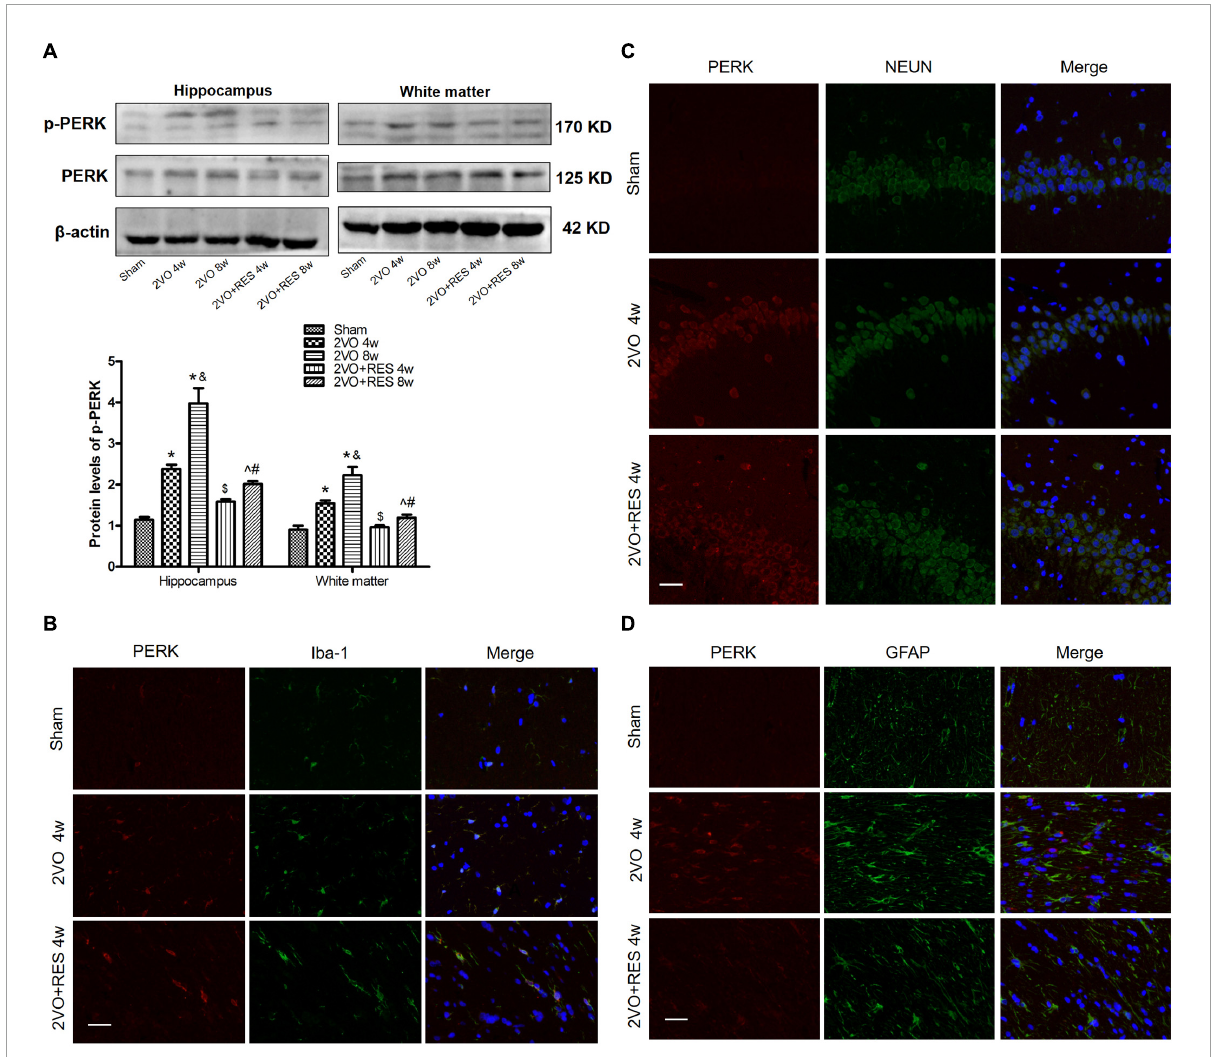
FIGURE8 Aberrant endoplasmic reticulum (ER)-stress in the bilateral common carotid artery occlusion (2VO) model is partially prohibited by resveratrol (RES). (A) The protein levels of PKR-like ER kinase (PERK) and p-PERK in white matter and hippocampus of different groups were measured by Western blotting. β -actin was used as an internal control ( n = 3 per group). The presence of p-PERK (red) in microglia (B) , neurons (C) , and astrocytes (D) was tested by immunofluorescence ( × 400, Blue, DAPI, n = 3 per group). * p < 0.05 vs. Sham; & p < 0.05, 2VO 8w group vs. 2VO 4w group; # p < 0.05, 2VO + RES 8w group vs. 2VO + RES 4w group; $ p < 0.05, 2VO + RES 4w group vs. 2VO 4w group; ˆ p < 0.05, 2VO + RES 8w group vs. 2VO 8w group. Data are presented as mean ±